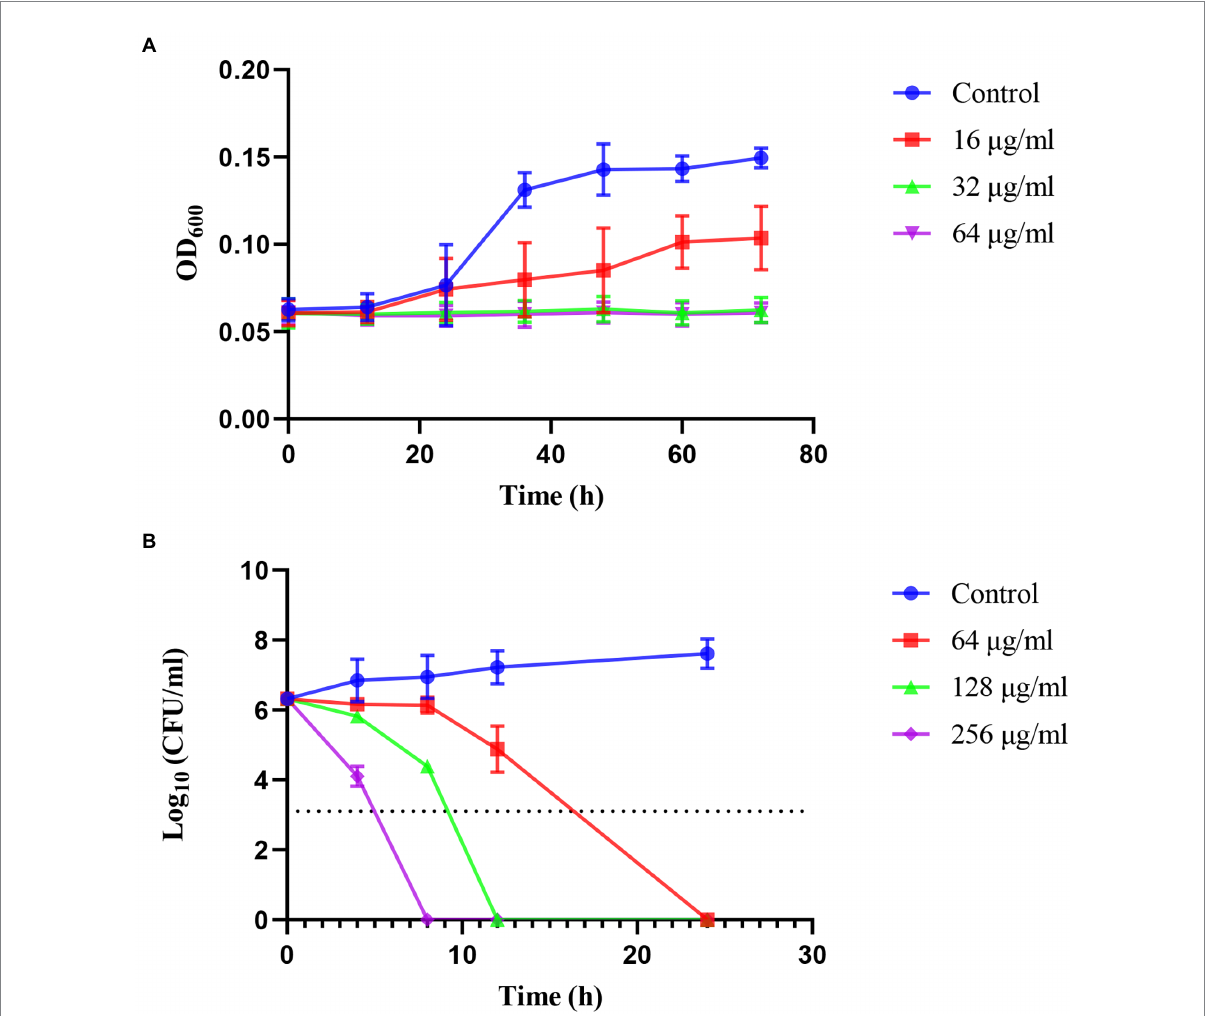
FIGURE 1 Inhibiting kinetic curves and killing kinetic curves. (A) Inhibiting kinetics curves of JWC on Helicobacter pylori 26,695–16R. (B) Killing kinetics curves of JWC on H. pylori 26,695–16R. The dotted line represents a 1,000-fold reduction in the number of bacteria compared to the initial